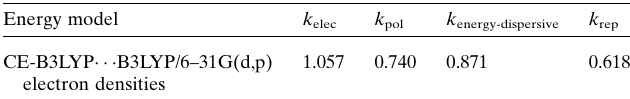
Table 2 Scale factors for the benchmarked energy